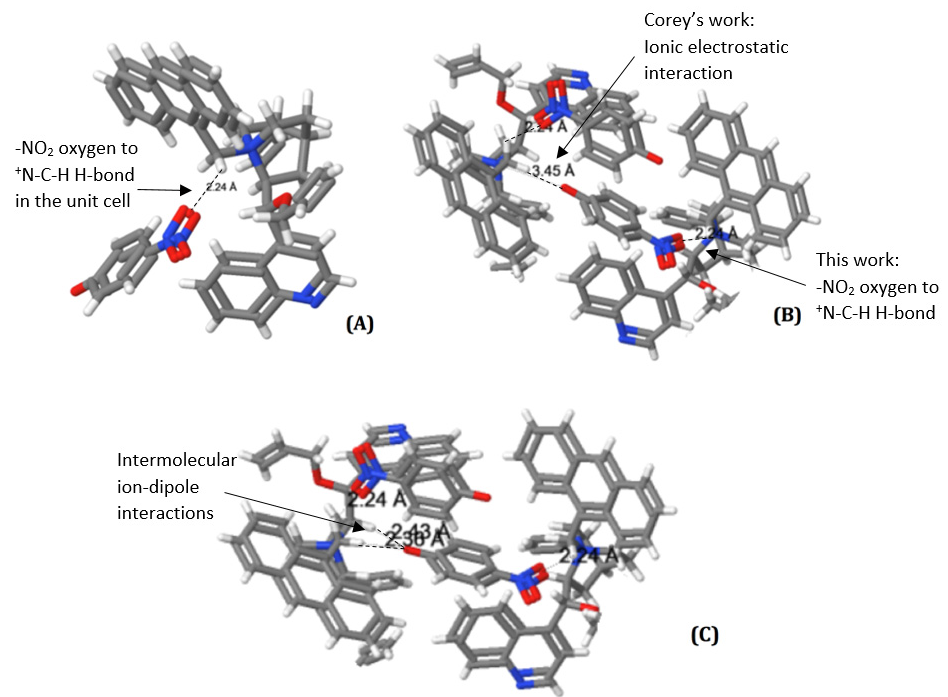
Figure 2. Re-evaluation of Corey and co-workers’ CCDC data for O (9)-allyl- N -(9-anthracenylmethyl)- cinchonidinium p -nitrophenoxide [13]. ( A ) Hydrogen bonding interaction between an + N-C-H proton to nitro oxygen of p -nitrophenoxide. ( B ) Comparison of (i) Corey’s alleged ionic electrostatic interaction based on observation of 3.45 Å distance between phenoxide oxygen and ammonium nitrogen, versus (ii) Our observation of a 2.24 Å hydrogen bond between an + N-C-H proton and nitro oxygen of p -nitrophenoxide. ( C ) Our observation of multiple hydrogen bonds (2.24, 2.36, 2.43 Å) between + N-C-H protons to both the phenoxide oxygen and nitro oxygen moeities of p